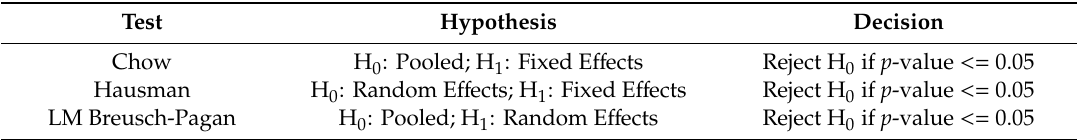
Table 4. Tests to choose the best panel regression model.